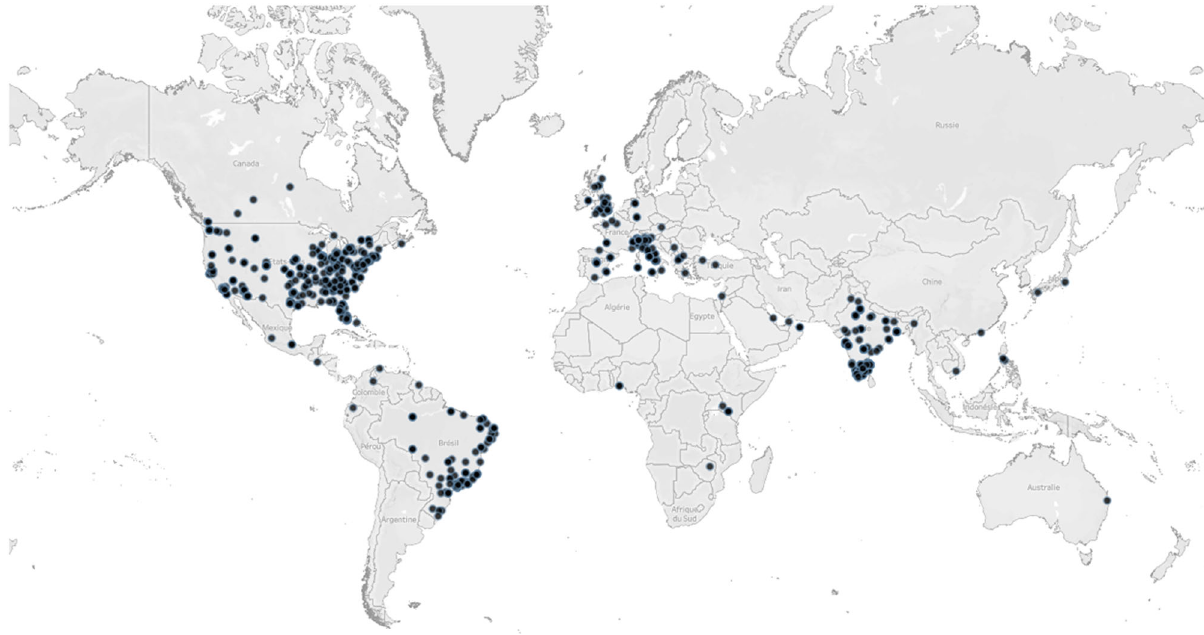
Fig. 1 Map of the location of participants: Blue dots represent the regional locations of study participants.